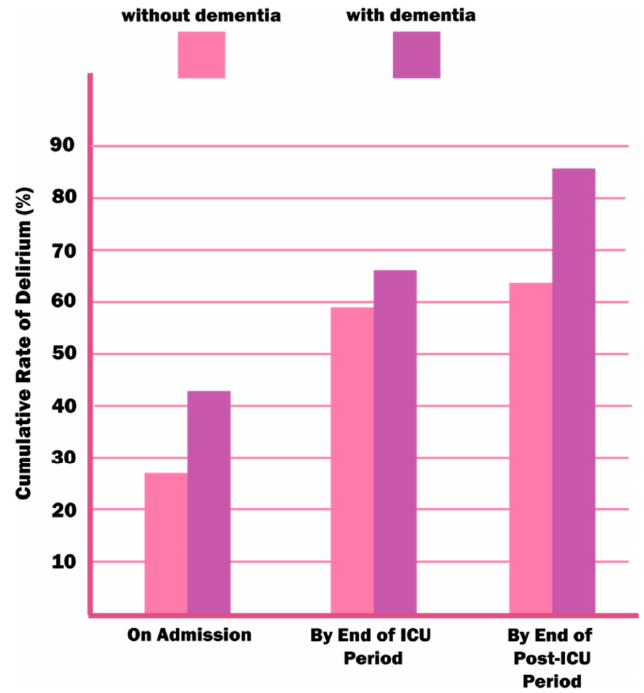
Figure 4. An estimated rate of delirium in patients with and without dementia in the ICU environment. Reproduced with permission from McNicoll L, Pisani MA, Zhang Y, Ely EW,